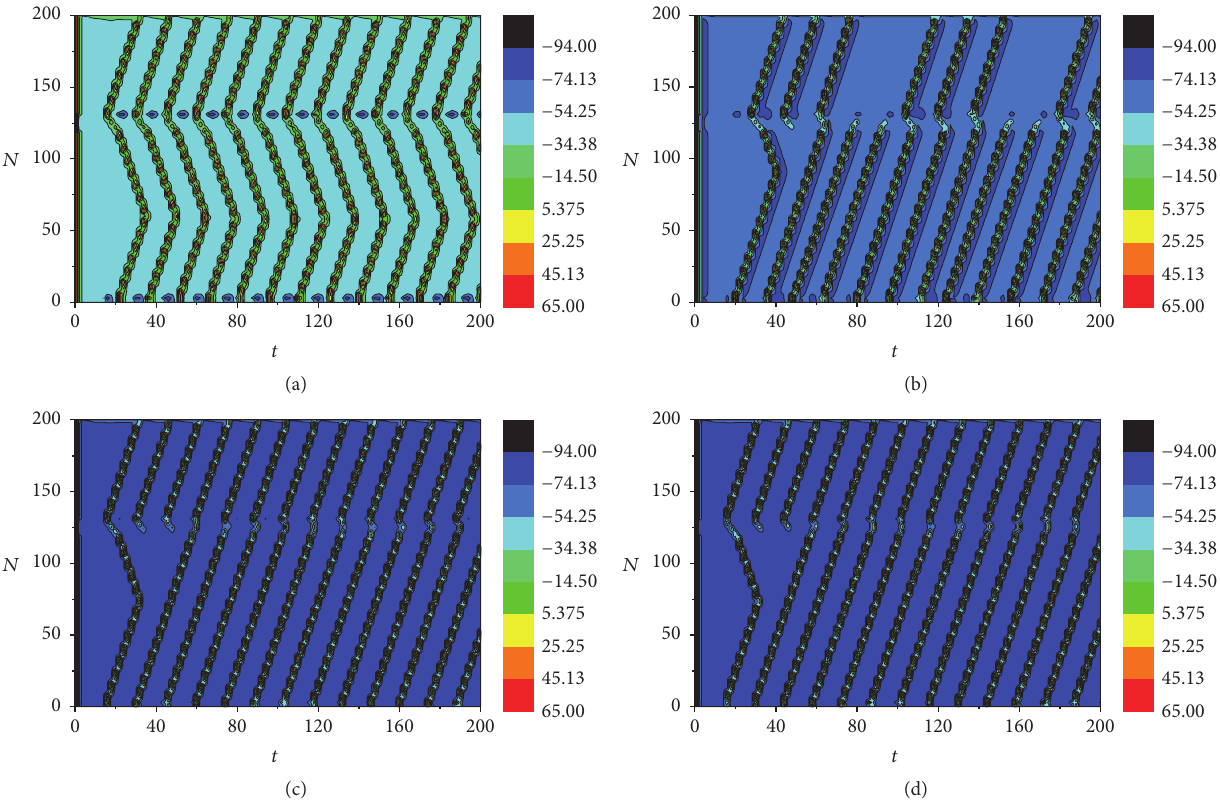
Figure 3: Wave propagation along axon when autapse is developed from node 𝑖 = 3,131 , for gains (a) 𝑔 𝑒 = −2 , (b) 𝑔 𝑒 = −1 , (c) 𝑔 𝑒 = 1.5 , and (d) 𝑔 𝑒 = 10 ; the time delay in electric autapse is set as 𝜏 = 14 and external forcing 𝐼 ext = 20 is imposed on node 𝑖 = 3 . The injured area generated by decreasing the conductance of sodium from 𝐺 Na = 120 mS/cm 2 to 𝐺 Na = 25.5 mS/cm 2 : the axon is divided into 201 nodes and the injured area is marked from nodes 𝑖 = 120 to 130 . The snapshots are illustrated in color